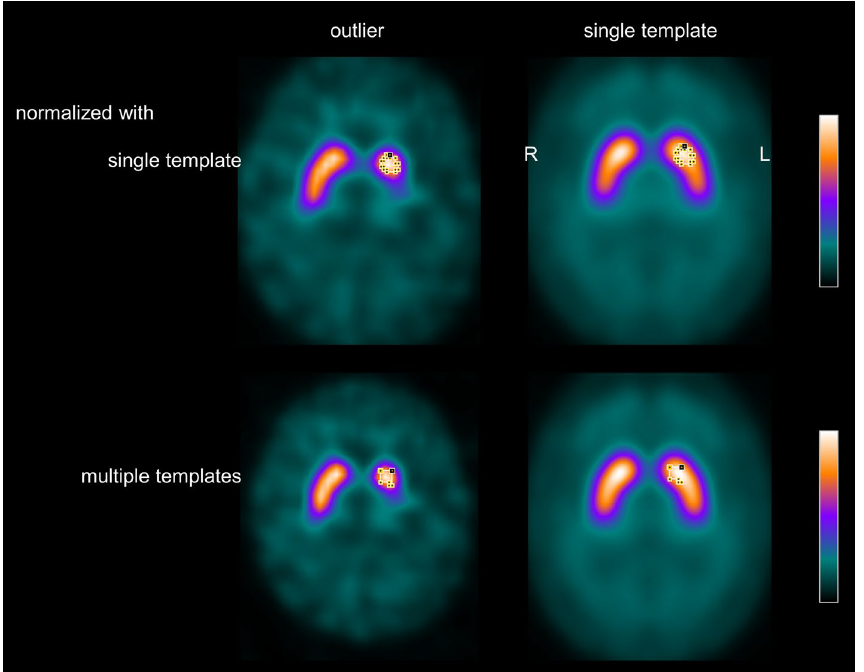
Fig. 7 Spatial shifting of the striatum by stereotactical normalization with the single template. The figure shows a transversal image of the DAT-SPECT of the outlier (red dot in Fig. 6) after stereotactical normalization with the single normal template together with this template (top row). The 80%-isodensity contour of the outlier’s left striatum was copied to the normal template. The bottom row shows the same for the DAT-SPECT image of the outlier after stereotactical normalization with multiple